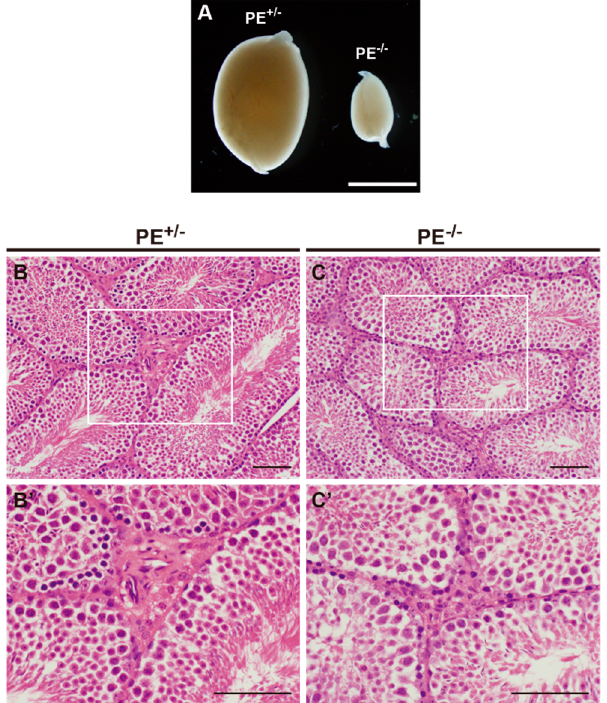
Figure 3. Severely impaired testicular architecture in PE − / − adult mice. ( A ) Macroscopic view of the testes collected from control and PE − / − mice. ( B , C ) Low magnification view of the HE stained section of testes collected from control ( B ) and PE − / − mice ( C ). ( B ’, C ’) Magnified view of the areas enclosed by open rectangles in ( B , C ). Scale bar: 2 mm in ( A ), 100 μ m in ( B – C ’).